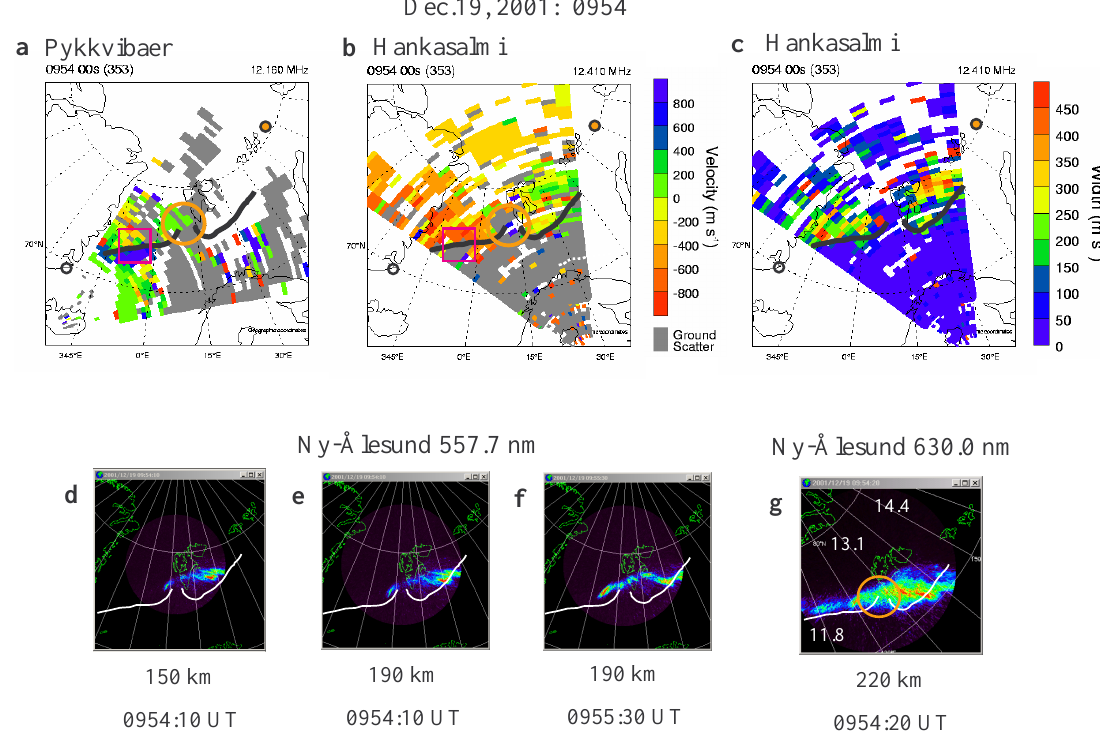
Fig. 11. Comparison of SuperDARN and optical data for the 2-min interval starting at 09:54